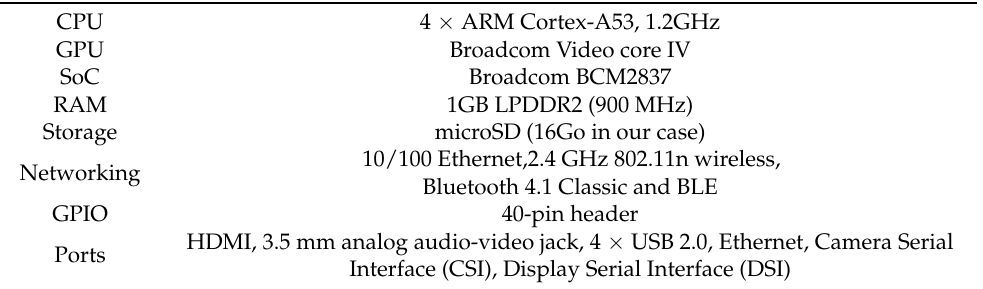
Table 3. Raspberry Pi 3 technical specifications.